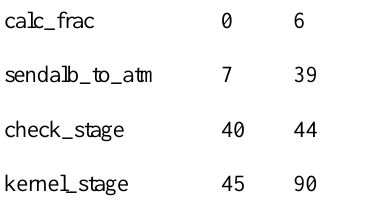
Figure 8. The runtime configuration file of the runtime procedures Fig. 6. The runtime configuration file of the runtime procedures for the coupler component in 2 for the coupler component in the FGOALS-gc. 3